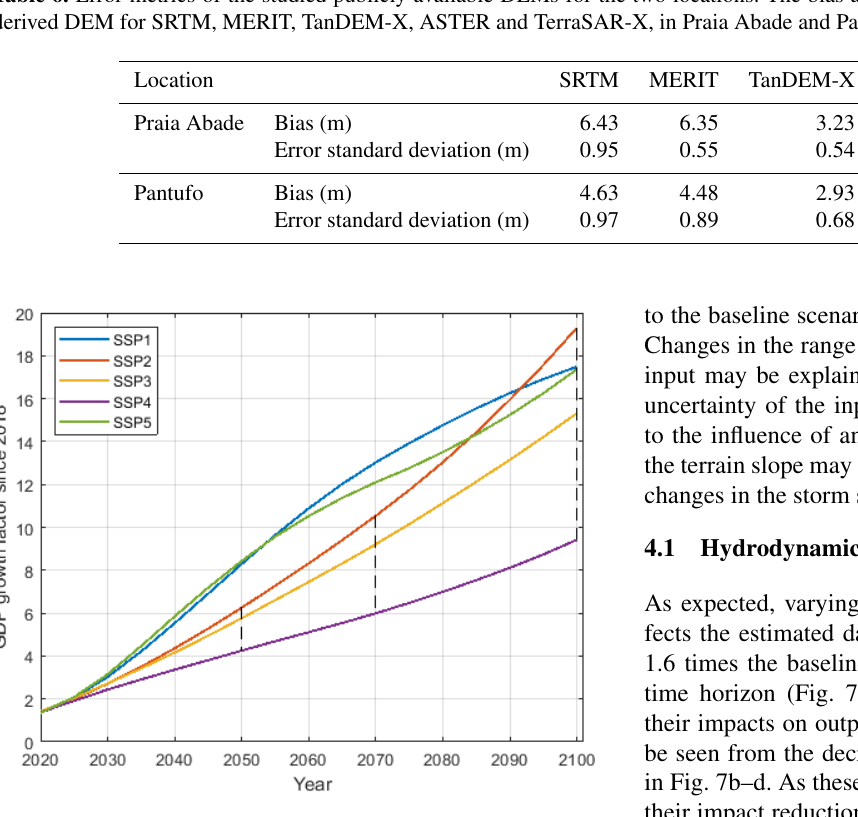
Figure 5. GDP growth factors for five different SSP scenarios through time. The different lines indicate the projected GDP growth according to the five SSPs. The black dashed lines indicate the three simulated time horizons and the range of used GDP